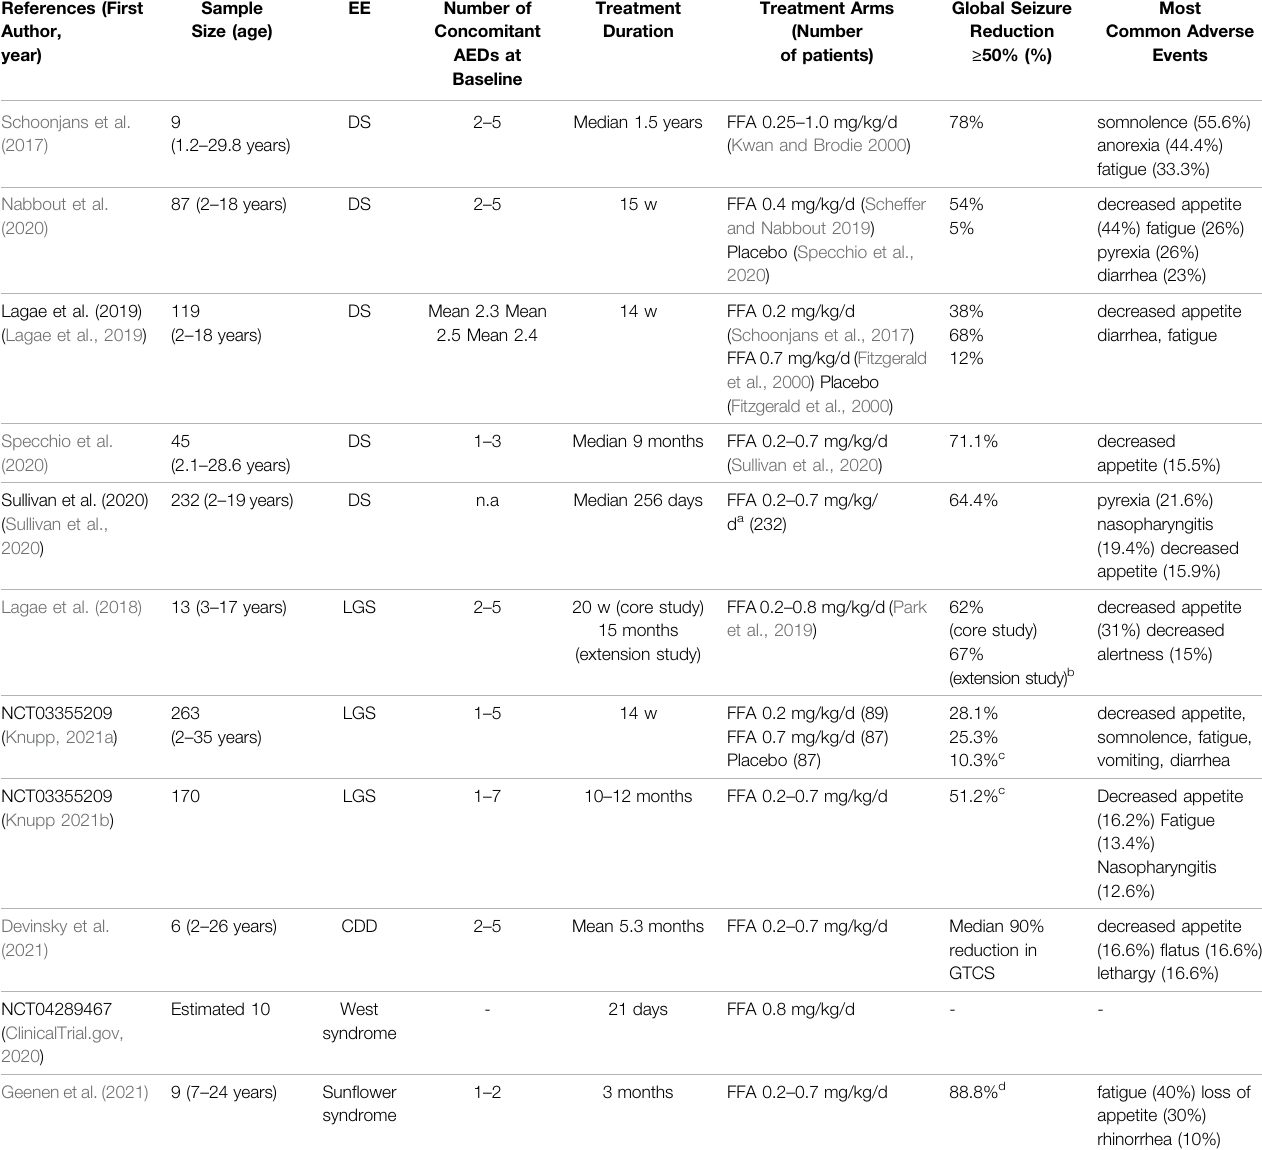
TABLE 1 | Main results from clinical trials for fenfuramine (FFA) use in pharmacoresistant